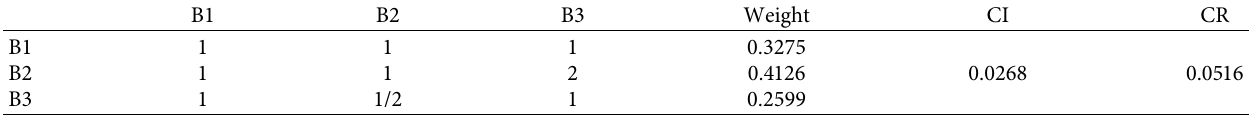
Table 10: Judgment matrix, weight distribution, and consistency test of the total model.